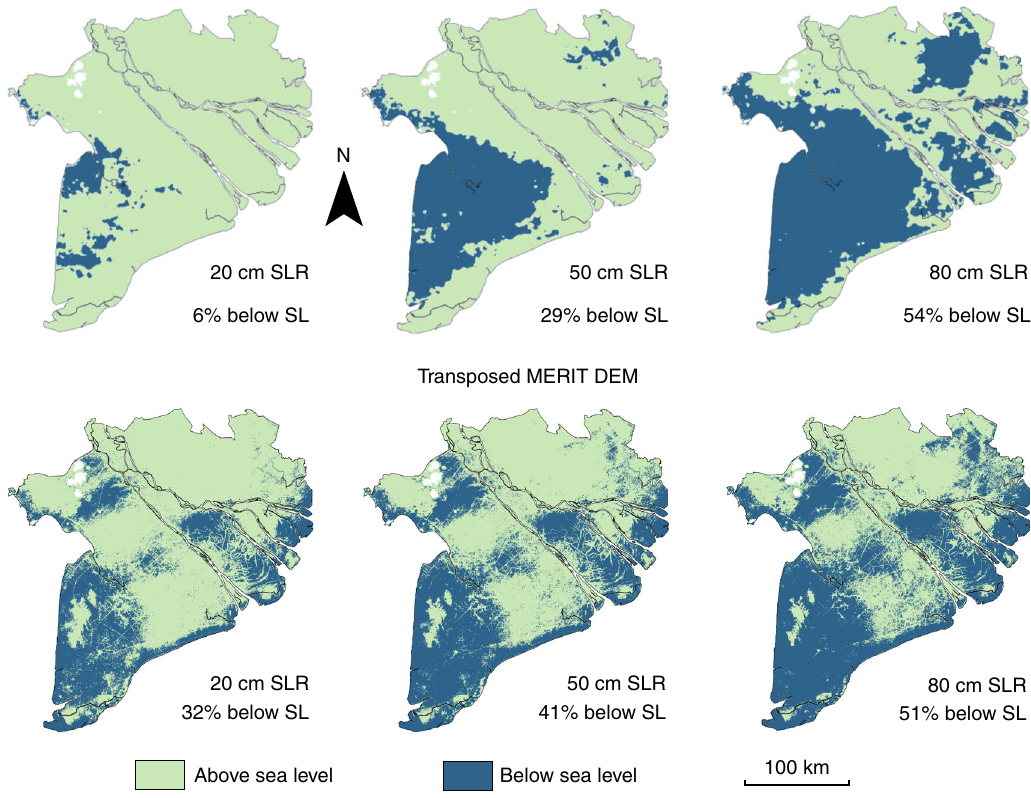
Fig. 5 Projections of area below sea with relative sea-level rise scenarios. Area below sea level (SL) for, respectively, 20, 50, and 80 cm relative sea-level rise (SLR) based on the Topo Digital Elevation Model (DEM) and the transposed MERIT DEM. The transposed MERIT DEM matches the mean delta elevation of the Topo DEM and was created by subtracting 2.5 m from the original MERIT DEM. The percentages give the area of the delta plain below sea level (excluding bed rock